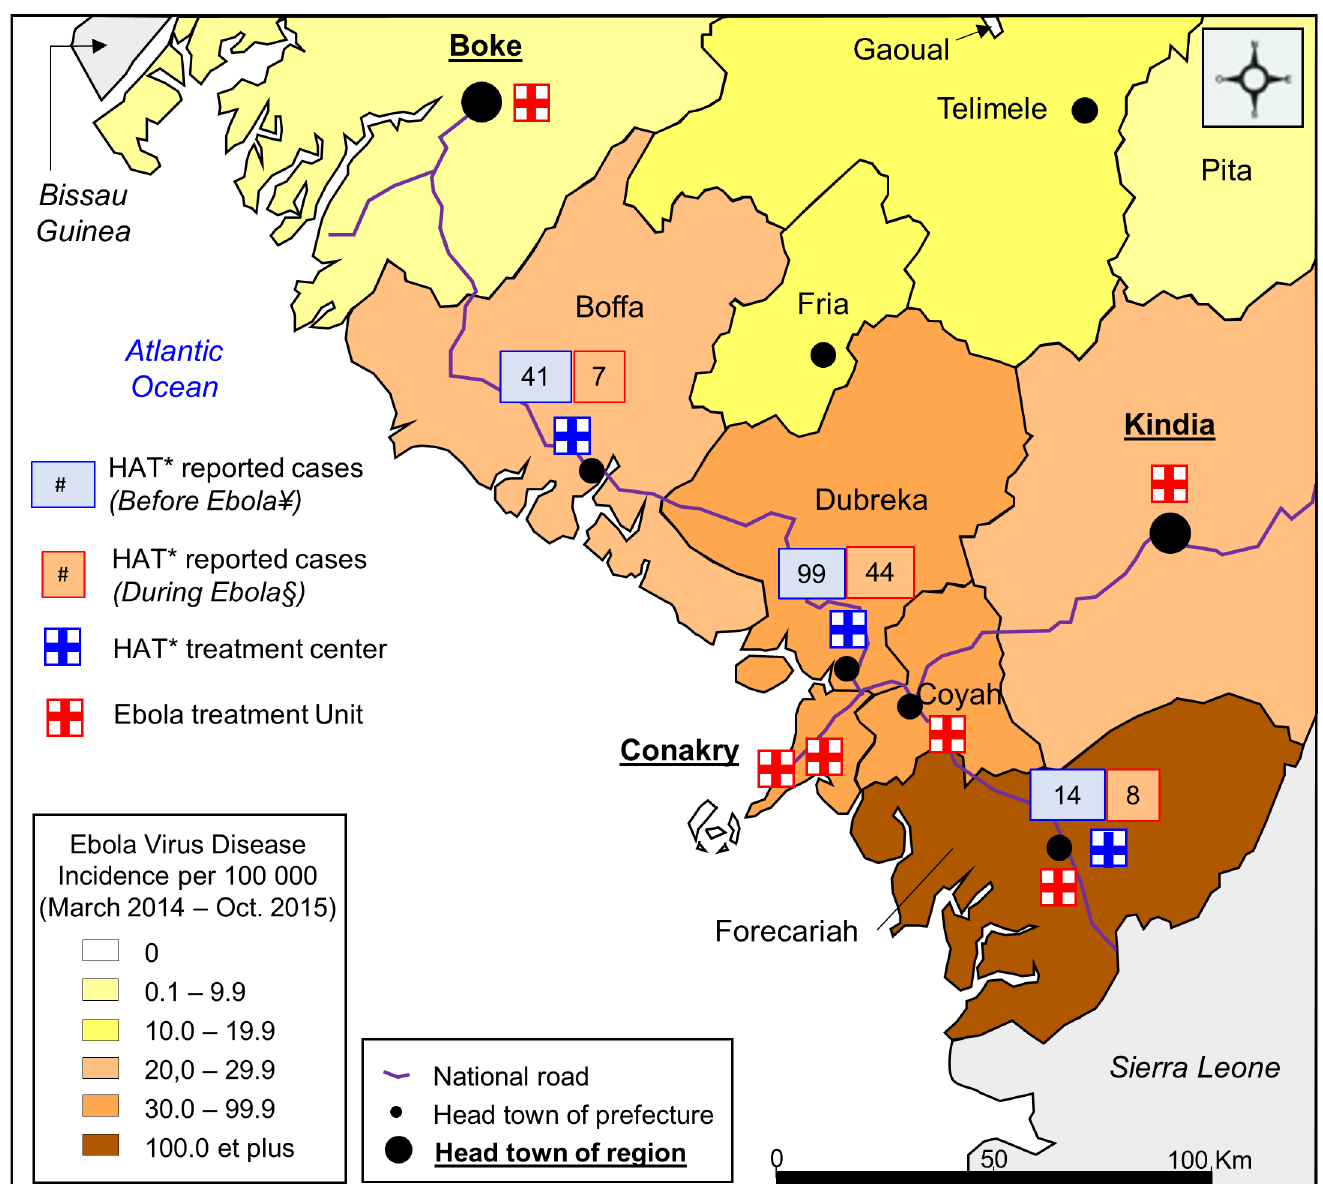
Fig 1. Ebola virus disease and HAT treatment centersspatial distribution. This figure shows the spatialdistributionof Ebola virus disease (EVD) incidencewith both EVD and Human African Trypanosomiasis (HAT) treatment centers and newly diagnosed HAT cases duringthe study period(before and during Ebola outbreak) in coastal Guinea. * HAT: Human African Trypanosomiasis. ¥ Before Ebola: from Feb.2012 to Dec.2013.§ During Ebola: from Jan.2014to